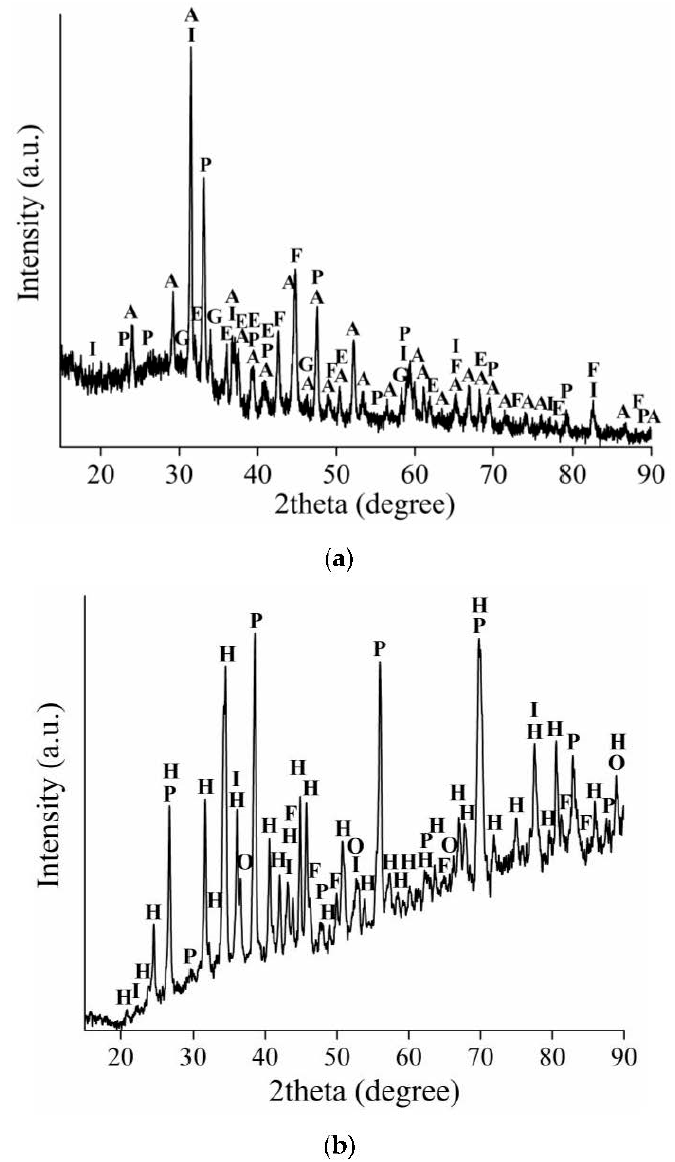
Figure 1. The XRD pattern of the WAT sample obtained using Cu-K α radiation ( a ) and the SSAT sample obtained using Co-K α radiation ( b ), where A—Ca 2 Al 2 SiO 7 ; P—CaTiO 3 ; F—Fe; G—Ca 3 Al 2 Si 3 O 12 ; E—Mg 3 Al 2 Si 3 O 12 ; I—MgAl 2 O 4 ; H—NaAlSiO 4 ; O—CaS.